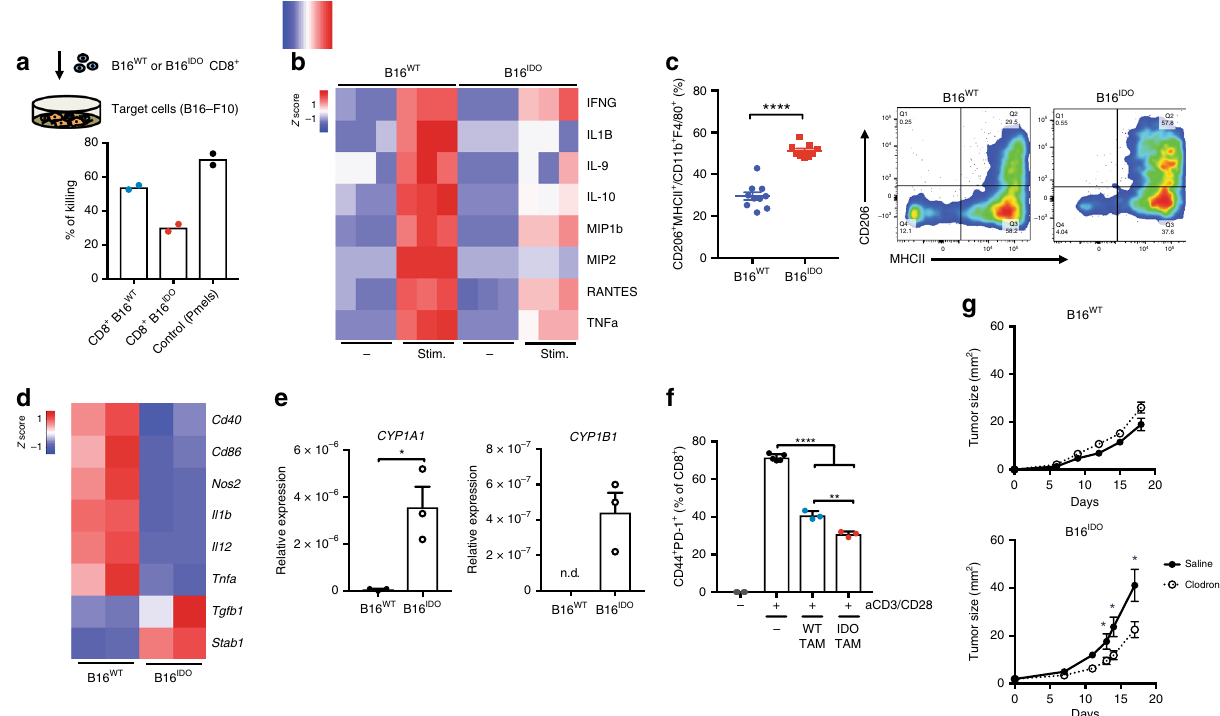
Fig. 2 IDO-overexpressing melanomas present a dysfunctional myeloid-enriched immune landscape. a Top: schematic representation of the experimental setup for the 3D collagen- fi brin gel killing assay and bottom, quanti fi cation of target cell killing by tumor-isolated CD8 + T cells or tumor- antigen (gp100)-speci fi c CD8 + T cells (pmels) (Data is representative of two independent experiments). b Multiplex analysis of cytokines from ex vivo tumor-isolated CD8 + T cells stimulated with aCD3/CD28 beads for 48 h. c , fl ow cytometric analysis and quanti fi cation of M2-like TAMs (CD206 + MHCII + in CD11b + F4/80 + ) cell populations in B16 IDO or B16 WT tumors at day 14 post implantation ( n = 10 (B16 WT ) and n = 9 (B16 IDO )). Results are representative of three independent experiments. d Heat-map of mRNA expression of M1 and M2 markers and e , of AHR-target genes in TAMs as determined by RT-PCR, data were relative to GAPDH expression and z-score normalized ( n = 3). f in vitro suppressive activity of TAMs puri fi ed from B16 IDO or B16 WT tumor-bearing mice at day 14 post implantation in CD8 + T cell activation state at a ratio of 1:2 CD8 + to TAMs ( n = 3). g Tumor progression of B16 IDO or B16 WT implanted in mice treated with clodronate liposome (1 mg/mouse) ( n = 8) or control ( n = 8). Results are representative of two independent experiments. Data is represented as mean values ± SEM. Two-tailed unpaired Student ’ s t test in ( c – e , g ) and one-way ANOVA test with Tukey correction in ( f ). P value: * P < 0.05, ** P < 0.01, *** P < 0.001, **** P <